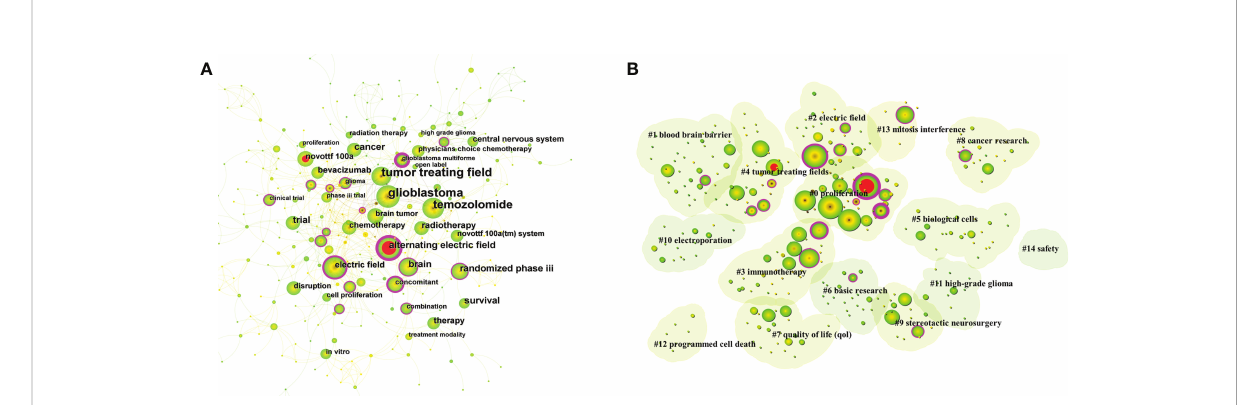
FIGURE 7 (A) Visual mapping of keyword co-occurrence for related publications. A circle represents a keyword, the larger the circle means the higher the frequency of that keyword, the purple ring of the outer ring represents having a high centrality. (B) Visual mapping of keyword clusters for related publications. Each cluster is a composition of multiple closely related words, forming a total of 15 clusters, with smaller numbers representing more keywords contained in that